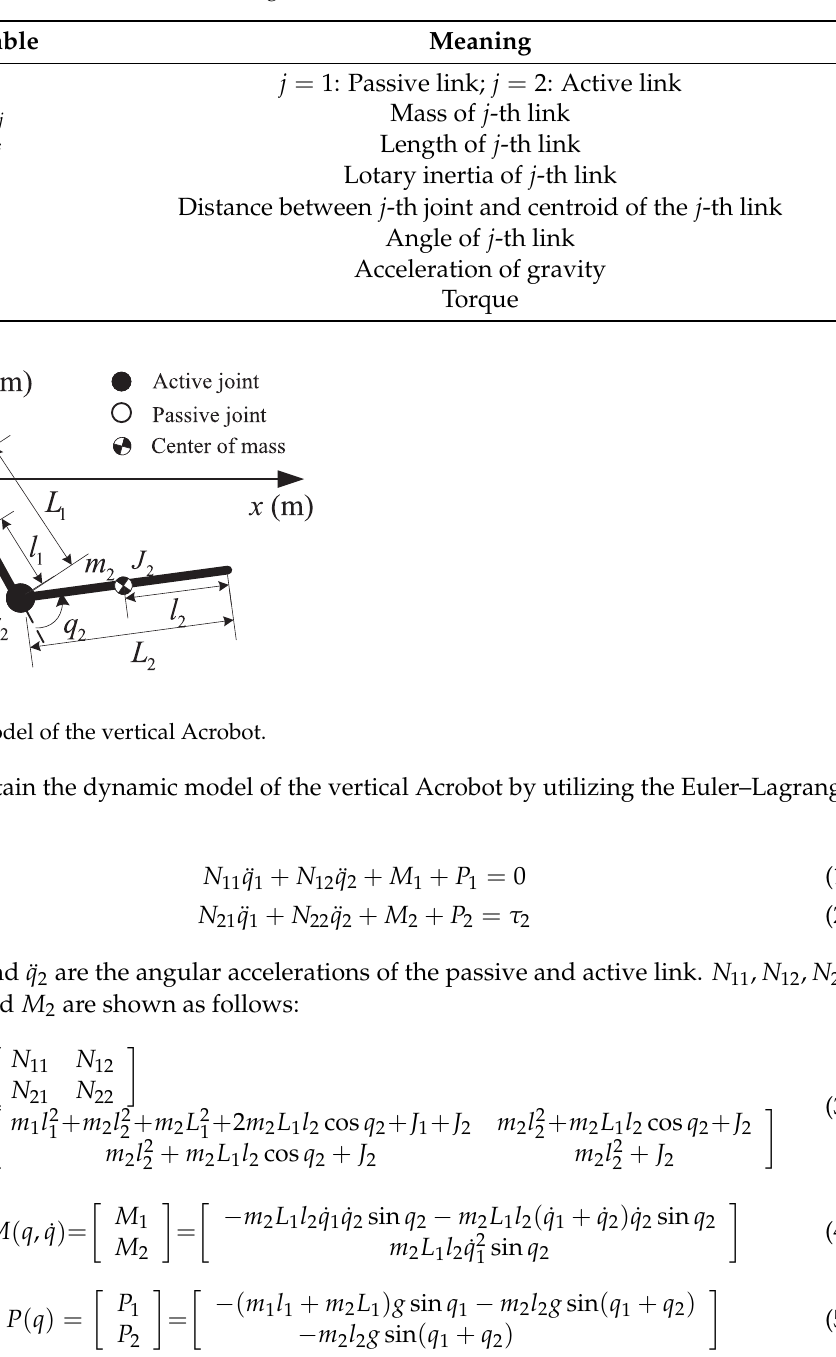
Table 1. Definition of the variables in Figure 1.